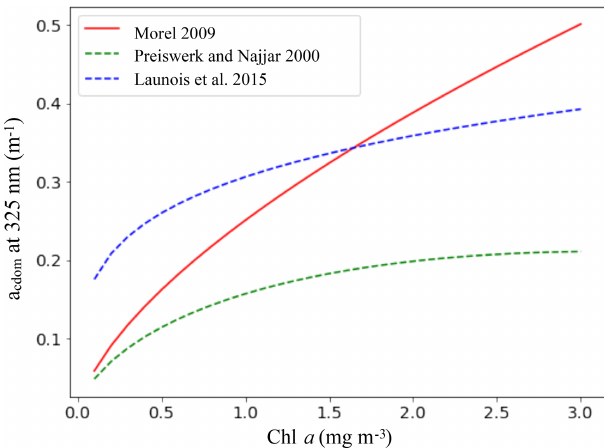
Figure 2. CDOM absorption coefficient (m − 1 ) at 325nm as a func- tion of the Chl a concentration (mgm − 3 ) for the parameteriza- tions of Morel (2009), Preiswerk and Najjar (2000) and Launois et al. (2015). The continuous line indicates the chosen parameteri-